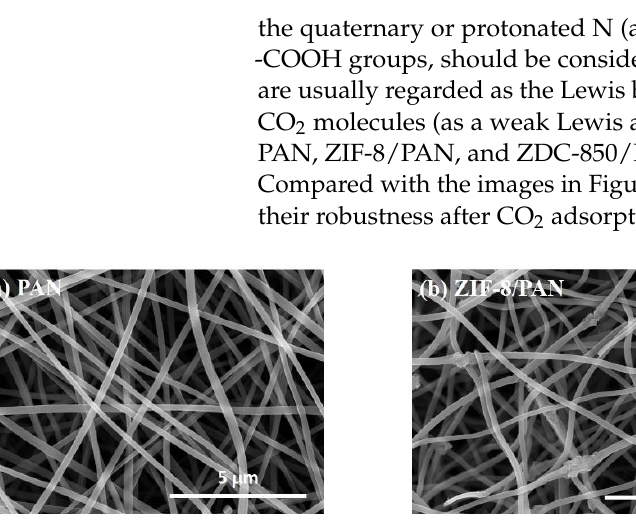
Figure 8. FESEM images of ( a ) PAN, ( b ) ZIF-8/PAN, and ( c ) ZDC-850/PAN after CO 2 adsorption. The Freundlich equation was used for the curve-fitting of the CO 2 measurement data. The consequences are summarized in Table 5 and also displayed in Figure 7a–e. As seen from the data, the values of K F varied inversely, proportionally to the adsorption temperature. The values of n ranged from 0.69 to 1.65 and were indicative of a feasible adsorption, except for ZIF-8. The Q st values varied with the CO 2 uptakes, as shown in Figure 7f, in which the Q st values log-linearly decreased with the CO 2 loading, from 0.6 to 2 mmol/g, indicating that the adsorption active sites on the surface of the adsorbents were energetically heterogeneous for CO 2 capture [65]. The data of ZIF-8 are shown in the inset of Figure 7f, due to its low adsorption capacities. Based on the Q st values, which were lower than 40 kJ/mol, we concluded that the CO 2 adsorption on the adsorbents belonged to a typical physical adsorption process. The Q st values had a lower CO 2 loading response to the CO 2 adsorption performance at low CO 2 partial pressures, indicating the interactions between CO 2 molecules and the surface functional groups or the enhanced micropore confinement [66]. The slope in the log–linear plot was highly related to their this study and various ZIF-8-related adsorbents in the literature, which implied that the CO 2 adsorption on the ZIF-8/PAN, ZDC-850, and ZDC850-PAN prepared in this study performed well for CO Table 5. Fitted results of the Freundlich equation for the CO 2 adsorption data collected on the sam- ples at different temperatures.